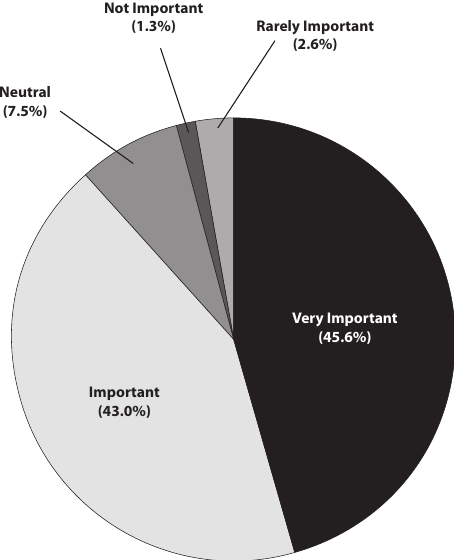
Figure 5. Respondents’ opinion of the importance of prehospital patient care reports to their